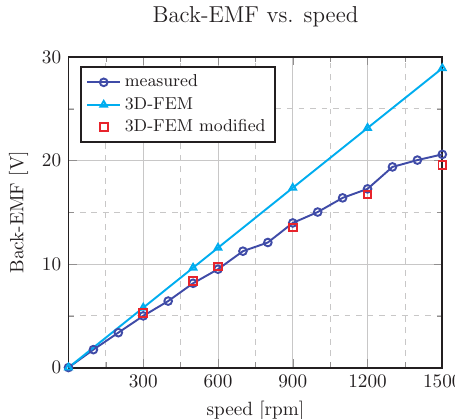
Figure 22. Back-EMF at various speeds rms